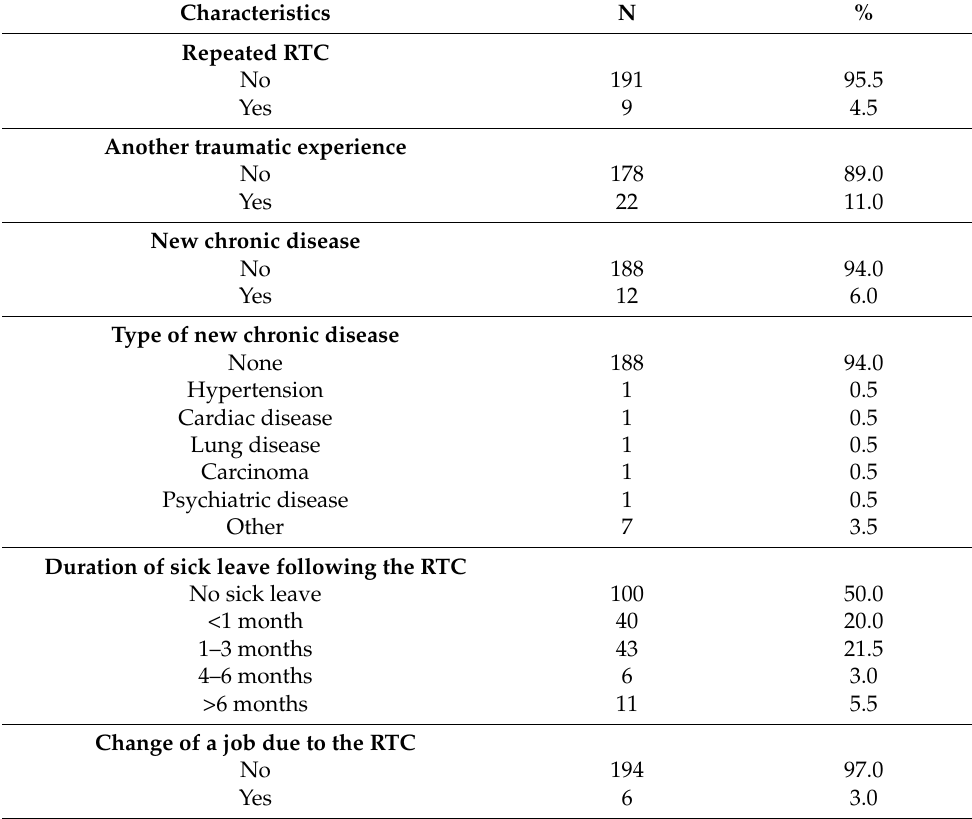
Table 7. Characteristics of the participants at 6-month